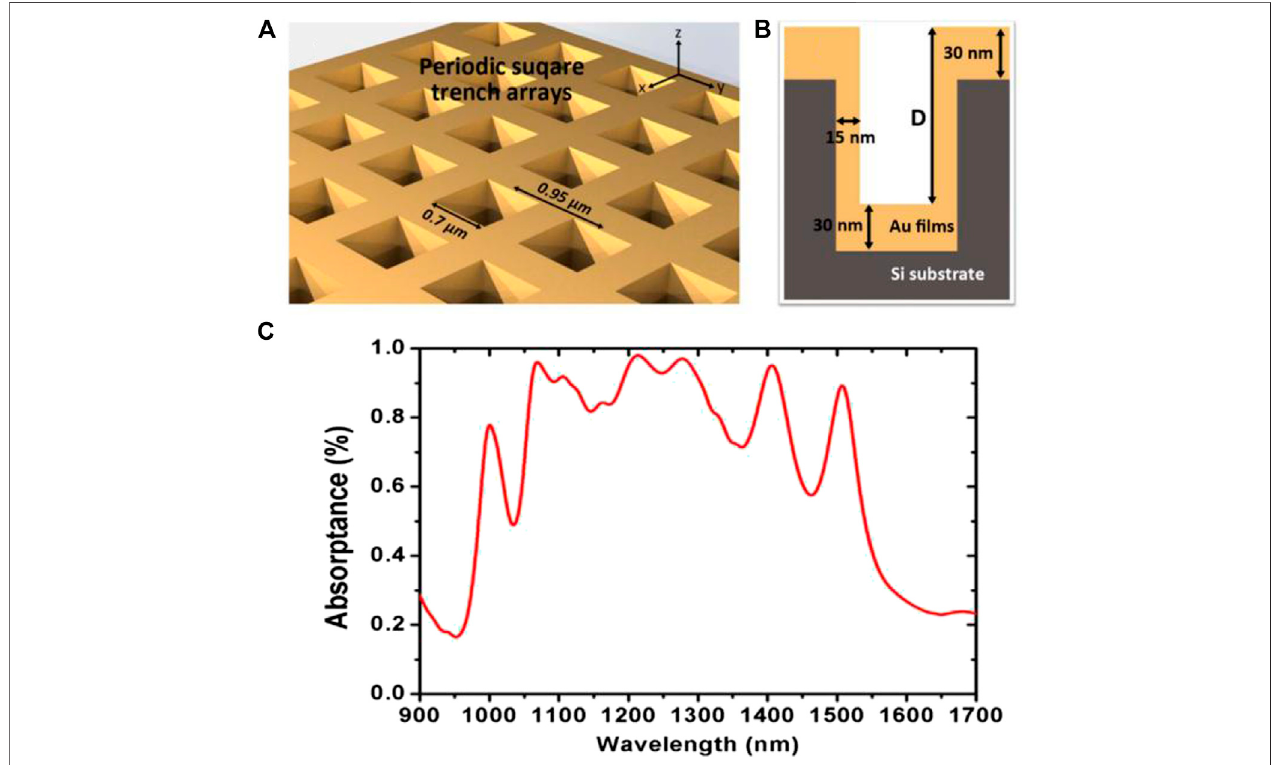
FIGURE 16 | The deep-trench microstructures (A, B) and corresponding response in the near infrared range from 1000 to 1500 nm with D (cid:1) 2.4 μ m (C) . Source : Reproduced from Ref. 36.